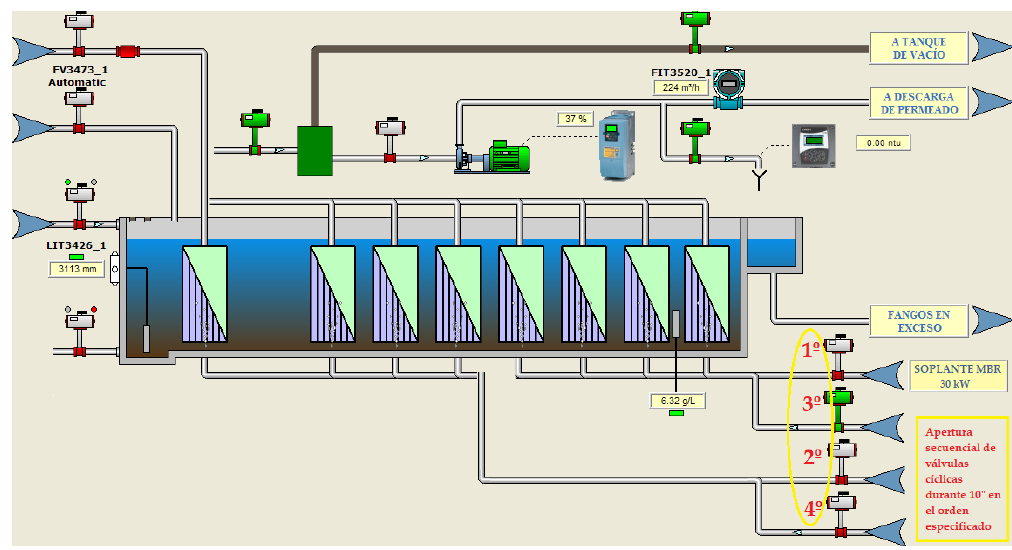
Figure 8. Actuation sequence of the aeration control valves in Single-train mode.